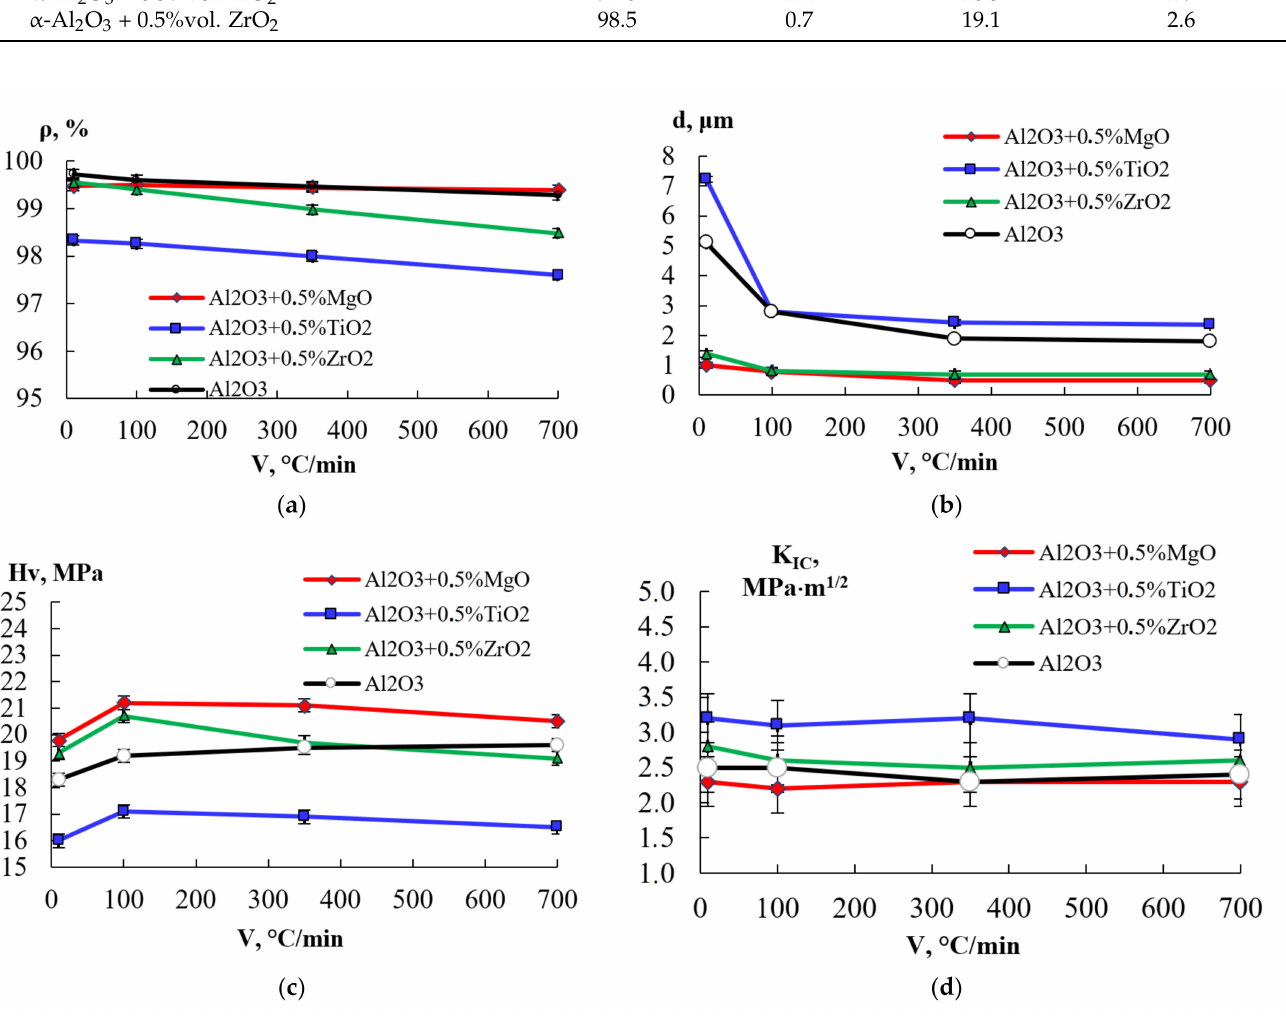
Figure 4. Mechanical properties: ( a ) density ρ ( V ) , ( b ) grain size d ( V ) , ( c ) hardness H v , ( V ) , ( d ) frac- ture toughness K IC ( V )